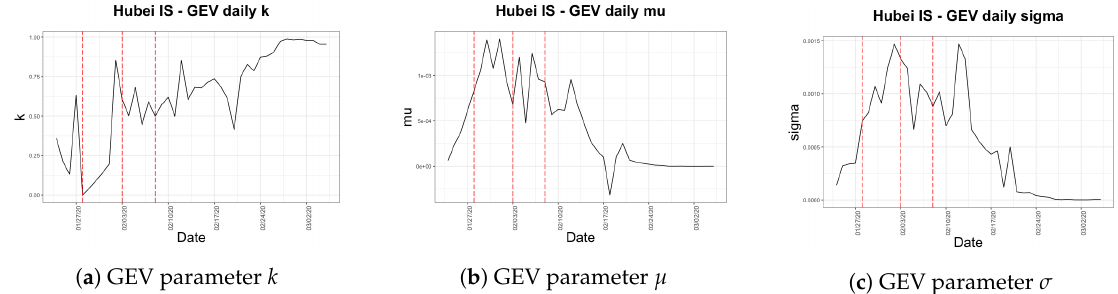
Figure 5. Time series for Hubei infection speed GEV